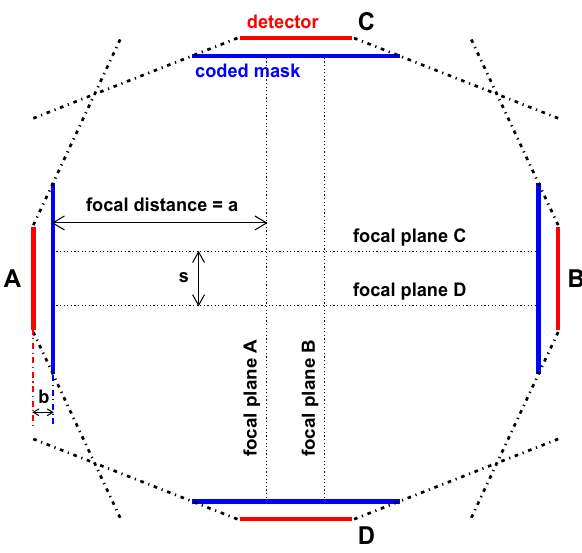
Fig. 3 Possible setup with couples of parallel devices (mask-mosaics and detectors). The distances a and b are for mask-focal plane and mask - detector, respectively. In this work the setup with s = 0 (coincident focal planes) is used for the simulation. Also a setup with s < 0 could be